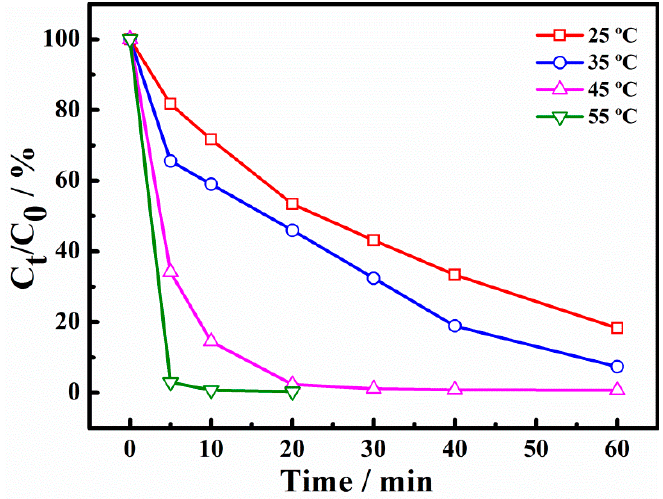
Figure 7. E ff ect of temperature on degradation of Figure 7. Effect of temperature on degradation of X-3B.